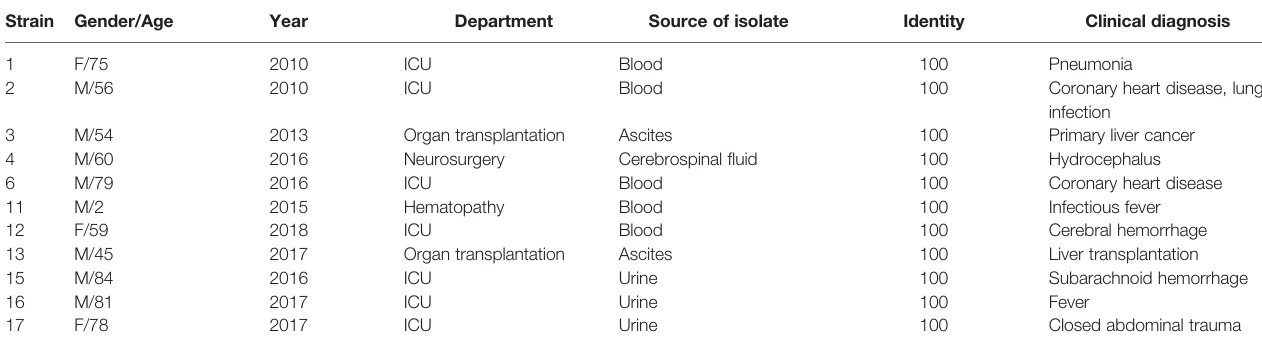
TABLE 1 | List of isolates included in the